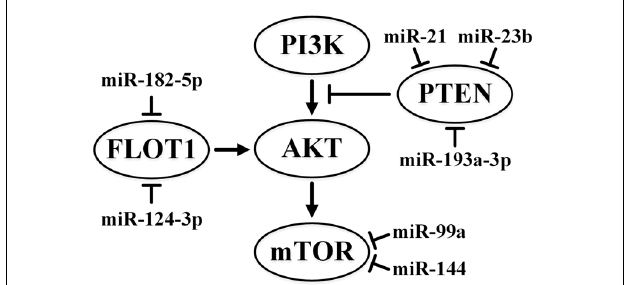
FIGURE 1 | Summary of the effects of miR-21, miR-23b, miR-99a, miR-124-3p, miR-144, miR-182-5p, and miR-193a-3p on the PI3K/AKT pathway in ccRCC. ↑ indicates activity stimulation and (cid:62) indicates activity suppression according to any of the